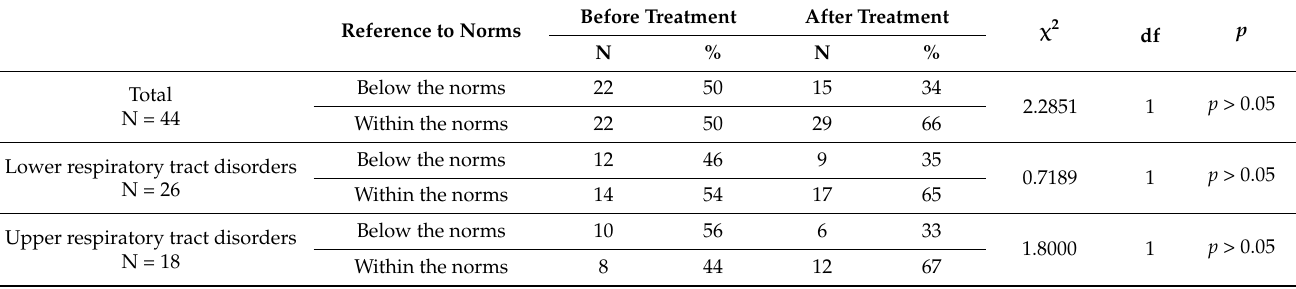
Table 4. The results of the study group’s chest mobility within the norms by Moll and Wright [32] before and after the treatment stay in the ‘Wieliczka’ Salt Mine Health